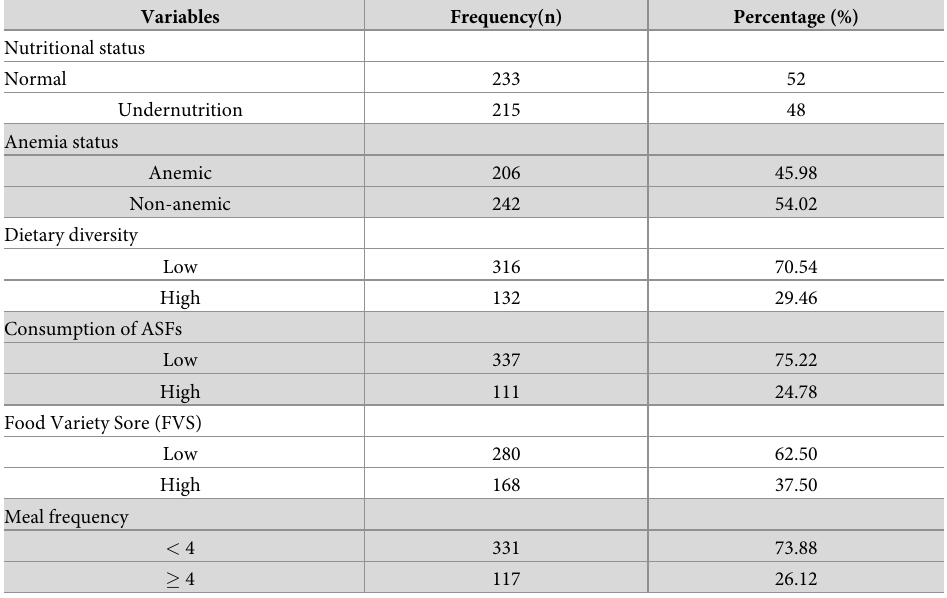
Table 2. Anthropometric and nutritional status of pregnant women in Haramaya district, eastern Ethiopia, 2021 (n =